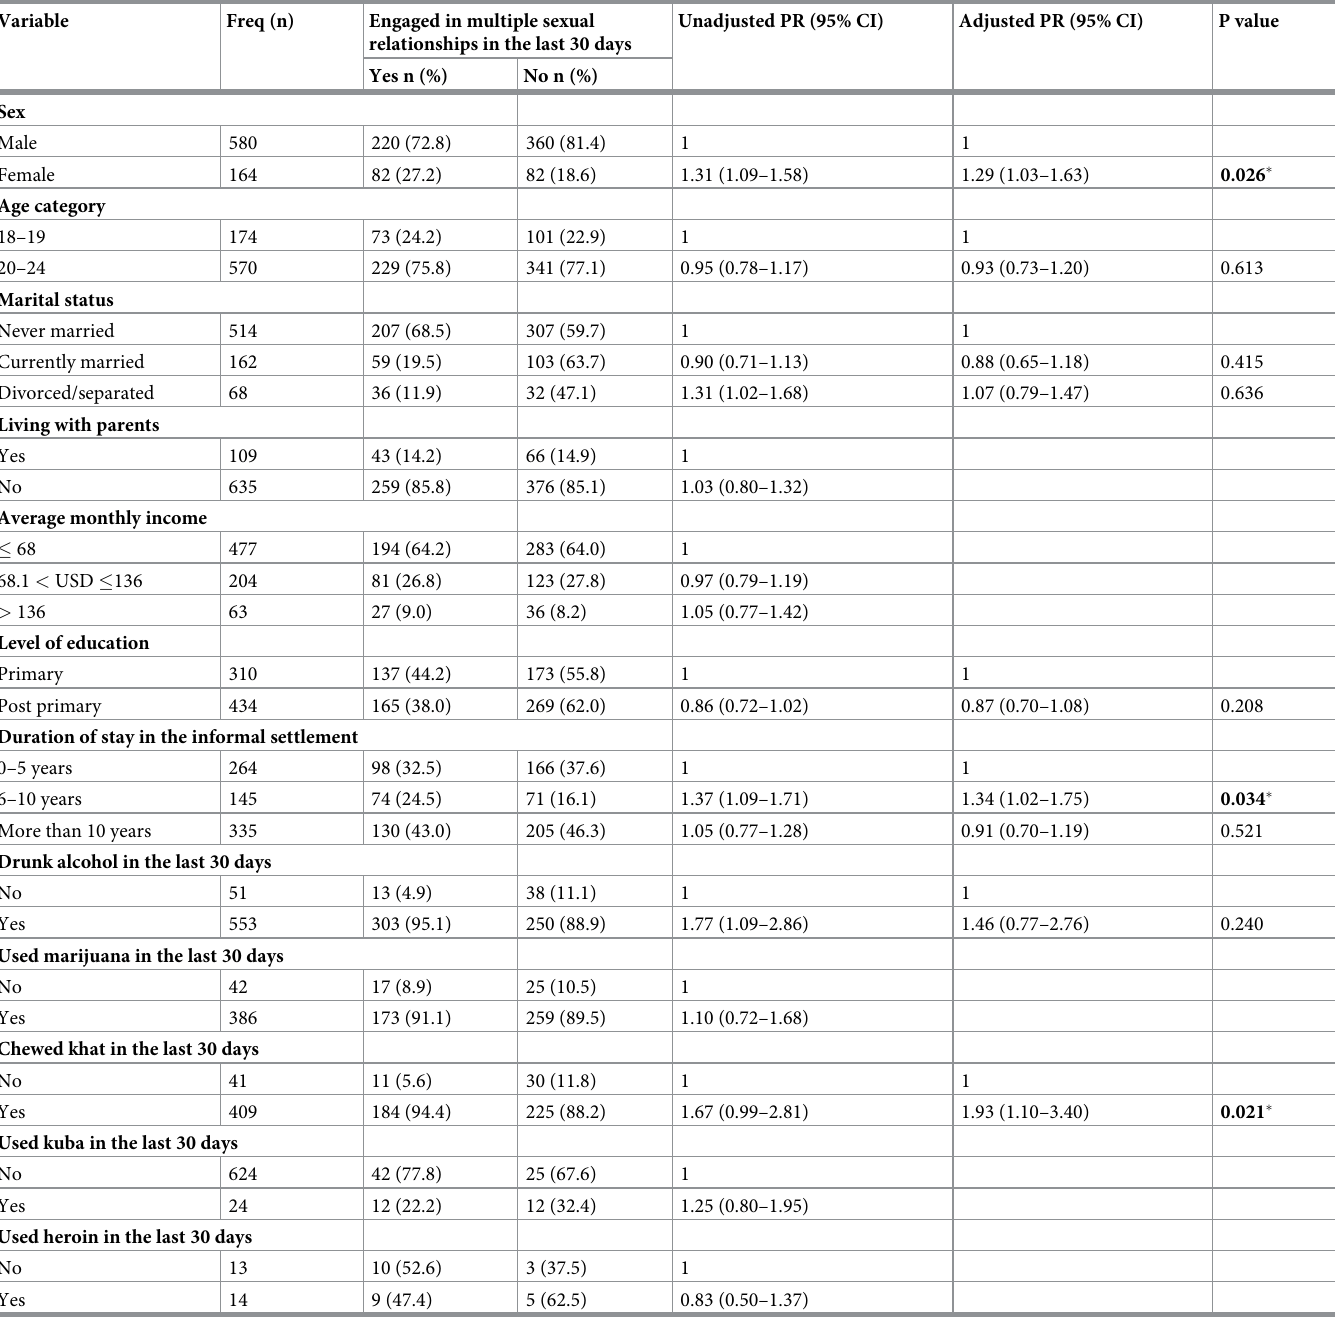
Table 4. Factors associated with engaging in multiple sexual relationships among young psychoactive-substance-users in informal settlements in Kampala.